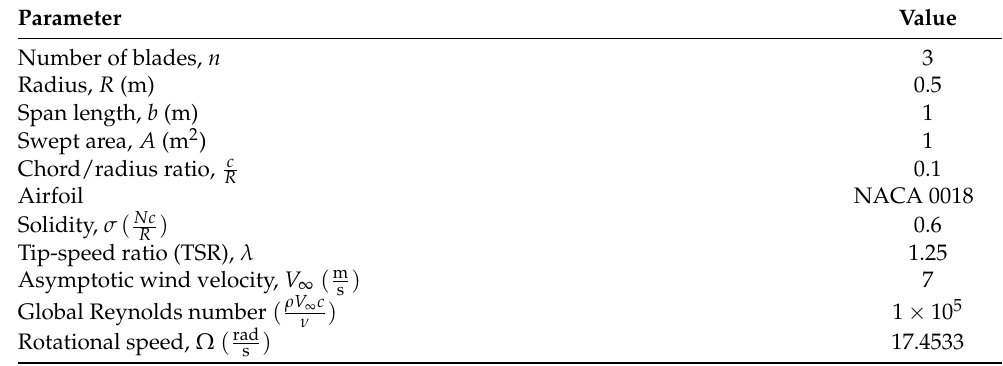
Table 1. Geometrical and operational properties of the VAWT under